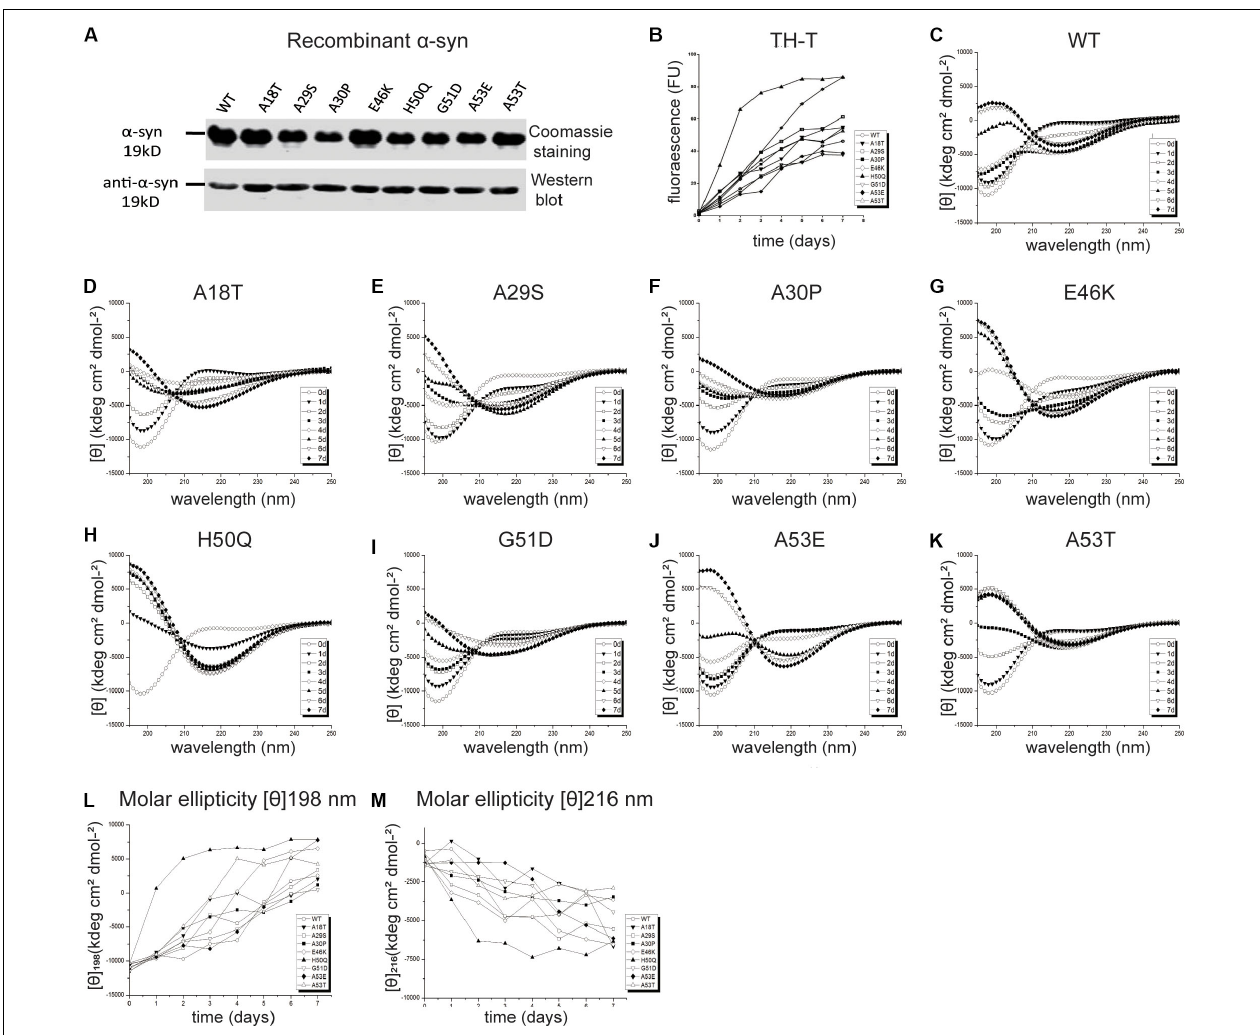
FIGURE 2 | Effects of pathogenic mutations on α -syn aggregation in vitro . (A) Coomassie staining and immunoblots of recombinant human α -syn (WT) and pathogenic mutants. (B) Thioflavin-T (Th-T) binding assays ( n = 3 independent experiments). (C–M) Secondary structure dynamics of α -syn ( n = 3